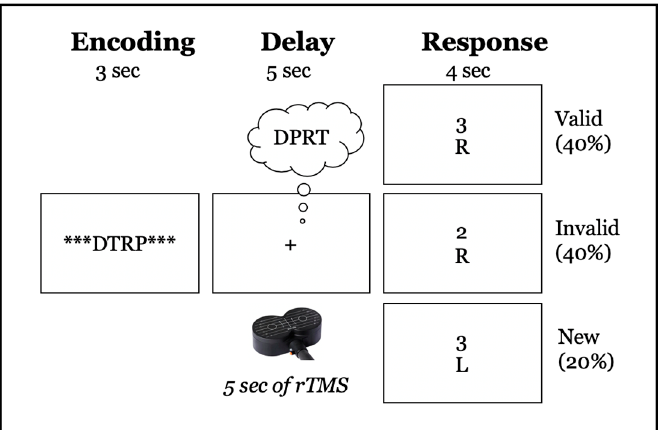
Figure 3. Schematic illustration of DRAT task. The top row shows an array of 4 letters (DTRP), presented for 3-seconds, that participants have to encode. Row two shows the 5-second delay period, during which participants had to maintain and reorganize the letters into alphabetical order (DPRT in the figure). Row three shows examples of the three possible responses: ‘new’: the letter was not in the original array; ‘valid’: the letter was in the array, and the number represented the correct position in the alphabetical order; ‘invalid’: the letter was in the array, but the number did not match the correct serial position when alphabetized.